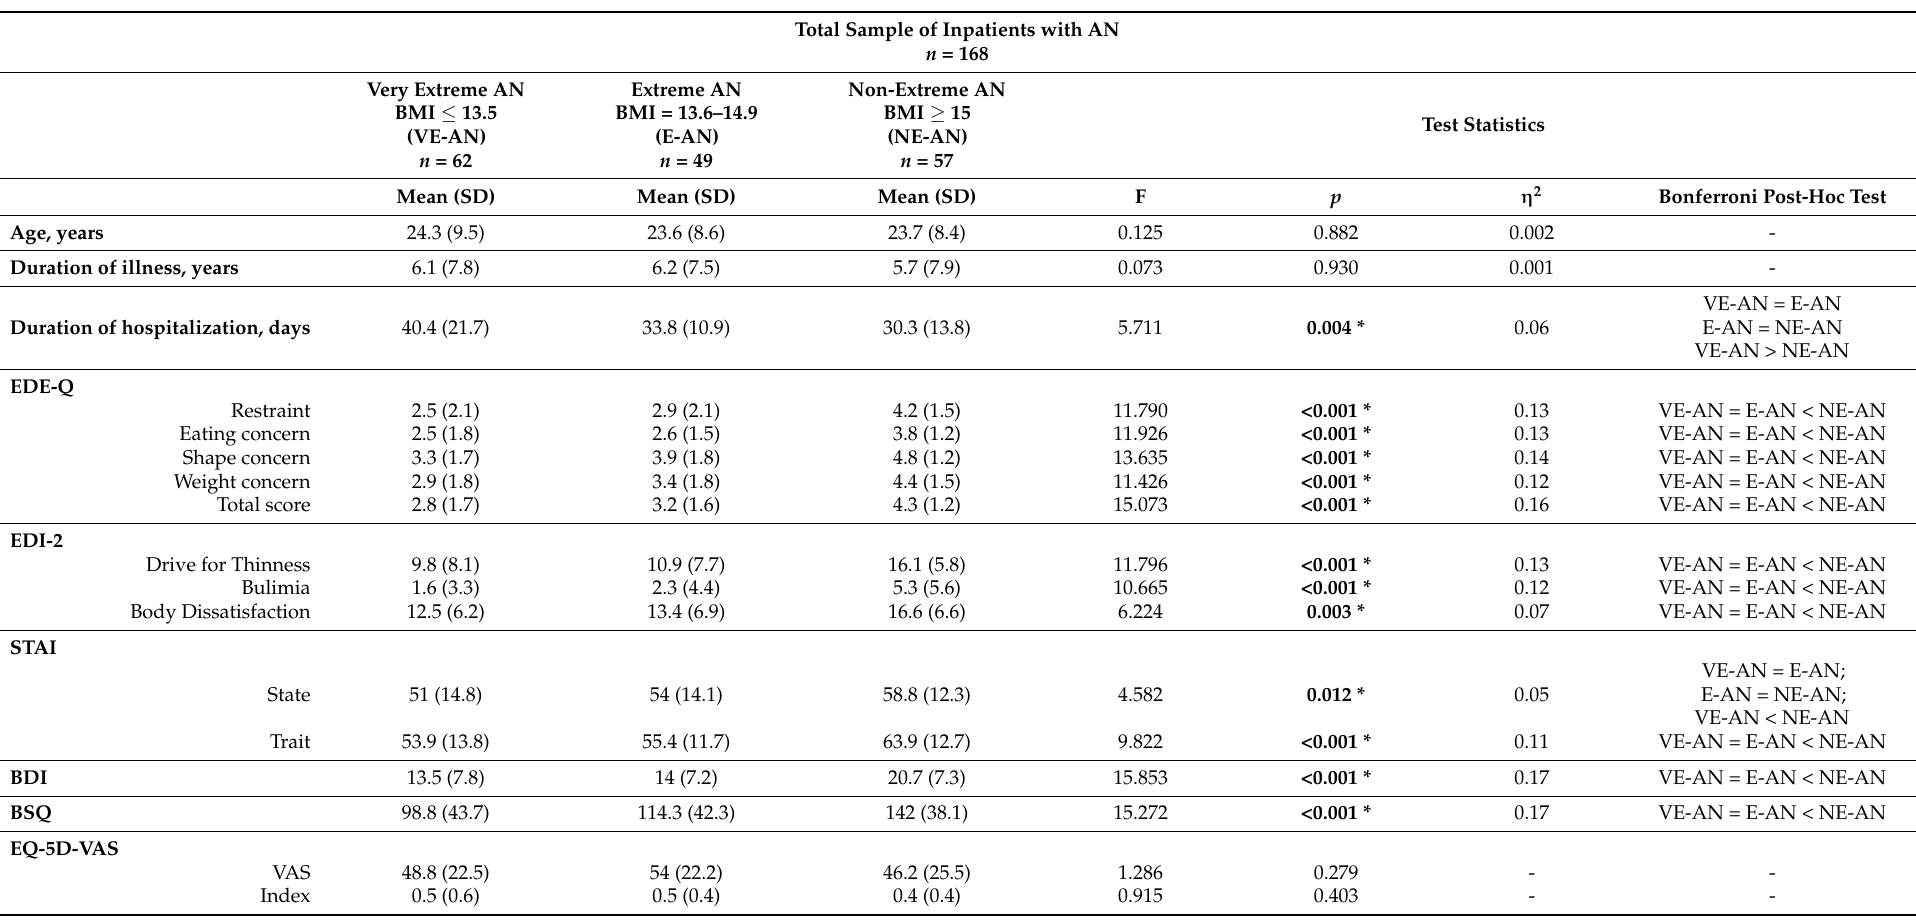
Bold text indicates statistical significance. * Significant after correction for the diagnostic subtype of anorexia nervosa. Magnitude of the effect: η 2 = 0.01–0.05 small; η 2 = 0.06–0.14 moderate; η 2 > 0.14 large. Legend: AN = anorexia nervosa; BMI = body mass index; EDE-Q = Eating Disorder Examination Questionnaire; EDI-2 = Eating Disorders Inventory-2; BDI = Beck Depression Inventory; STAI-T = State-Trait Anxiety Inventory-Trait; STAI-S = State-Trait Anxiety Inventory-State; BSQ = Body Shape Questionnaire; EQ-5D-VAS: EuroQoL Health Questionnaire/Visual Analogue